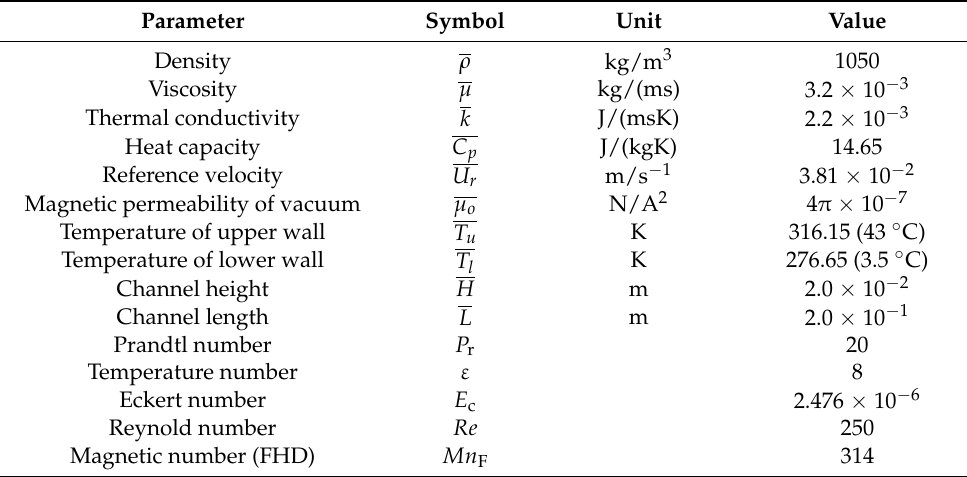
Table 1. Dimensional variables for biomagnetic flow in a rectangular